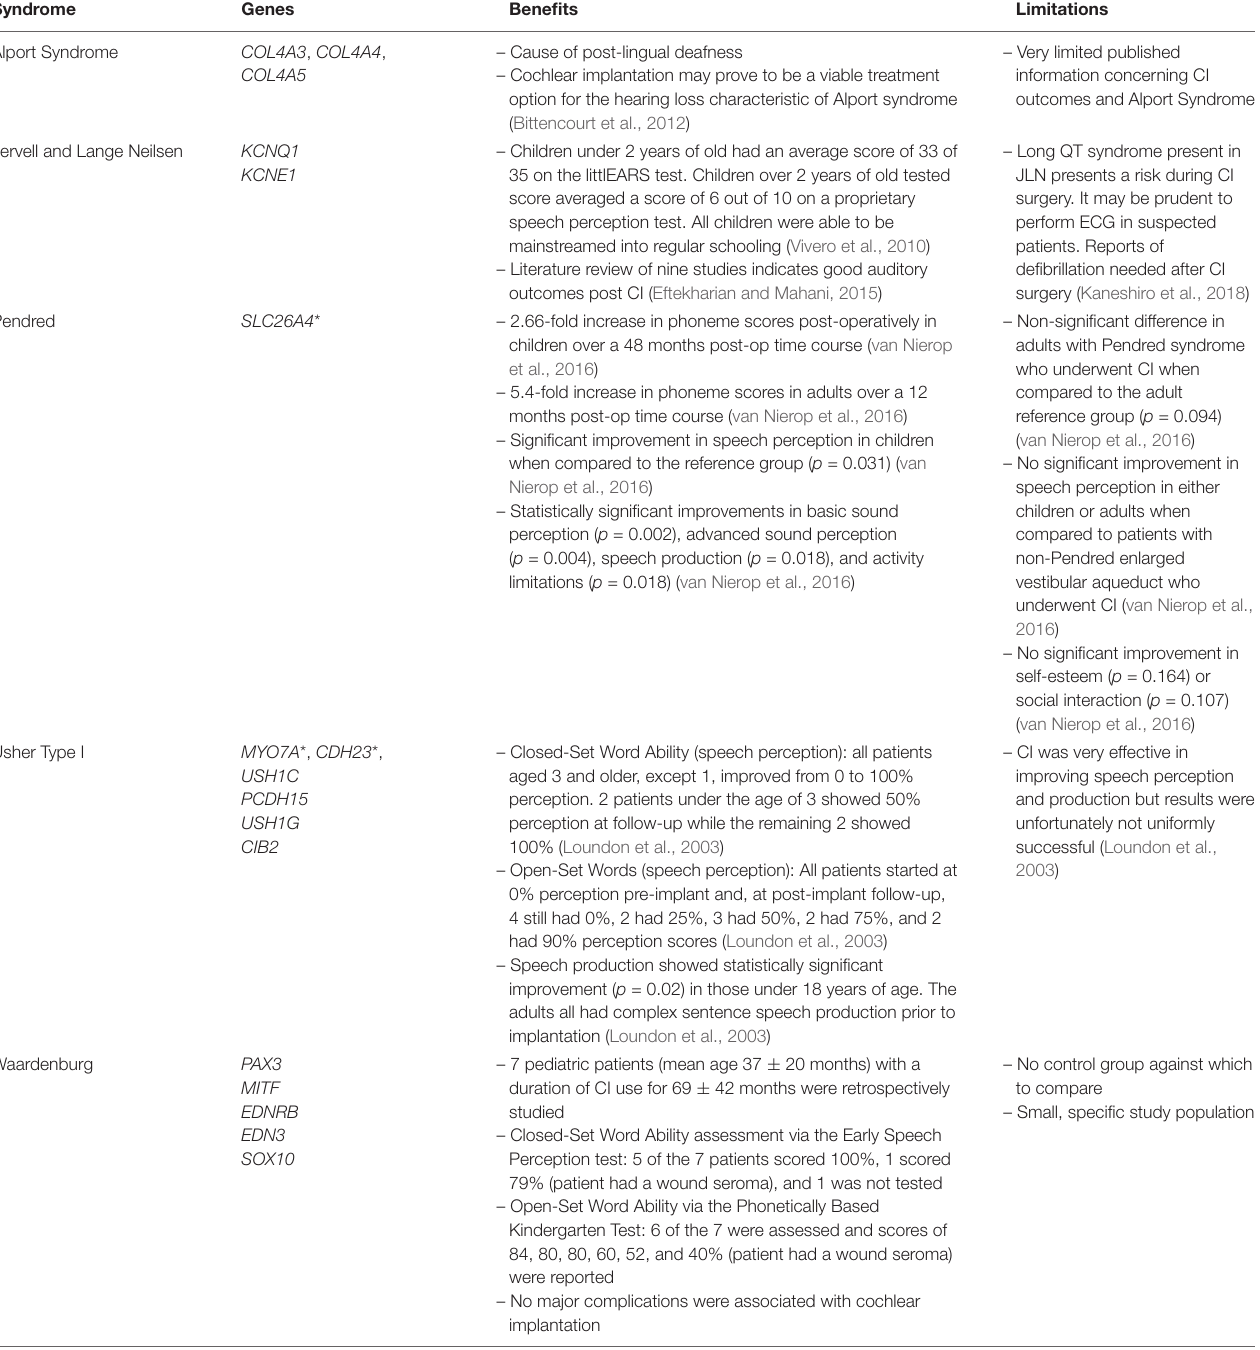
TABLE 2 | Most common syndromic causes of